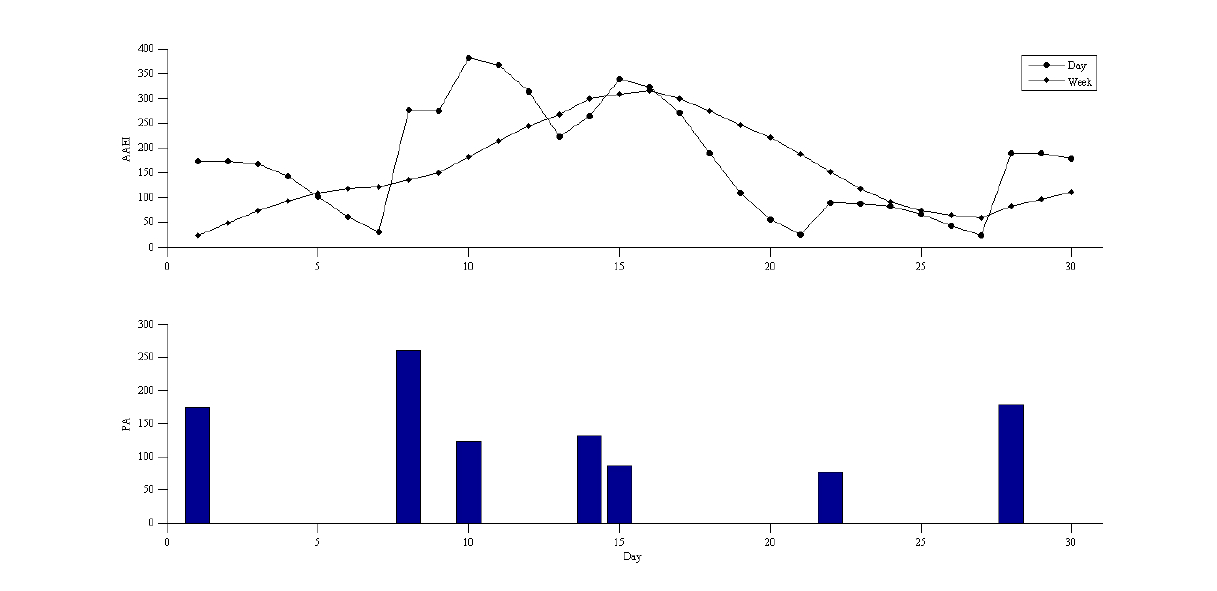
Figure 9. AAEI with physical activity (PA) of participant